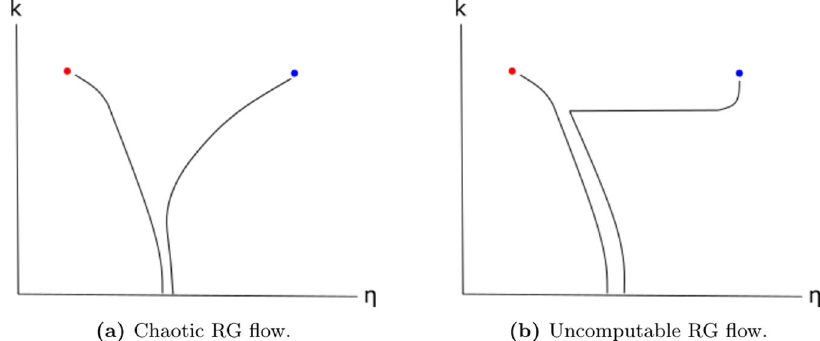
exponentiallyin k ,according tosomeLyapunovexponent.Intheundecidablecase ( b ),theHamiltoniansremainarbitrarilycloseforsomeuncomputablylargenumber of iterations, whereupon they suddenly diverge to different fi xed